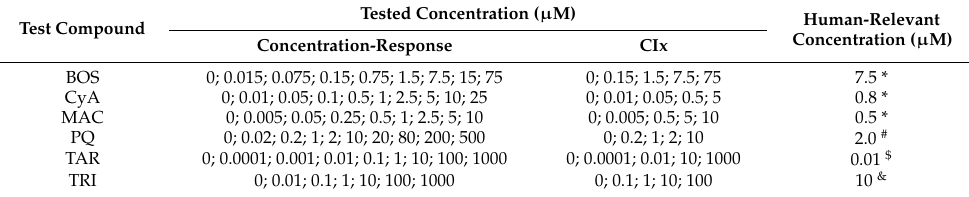
Table 2. Concentrations of test compounds for the concentration–response curve and the CIx exper-